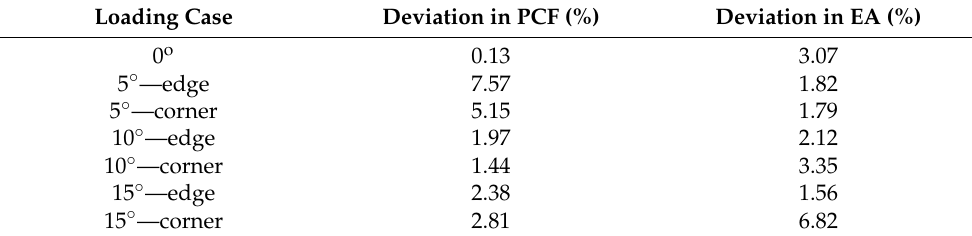
Figure 8. Experimental and numerical results of 15 ◦ crushing angle for cornered and edged oblique impact. ( a ) force-displacement curve; ( b ) EA-displacement curve. Table 4. Deviation in PCF and EA between experiments and